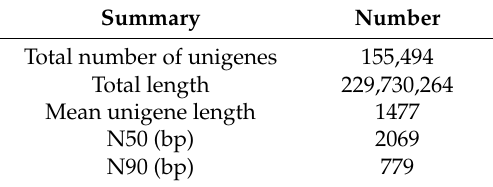
Table 1. Summary for the outcome of the reference sequences using the four datasets in D. latiflorus. Summary